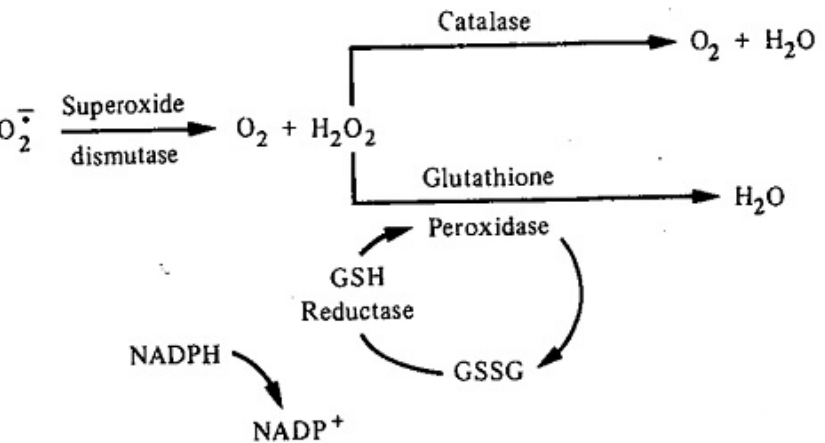
Figure 3. Schema Depicting Major Antioxidant Enzymes Involved in Maintaining Intracellular Redox Balance [22].